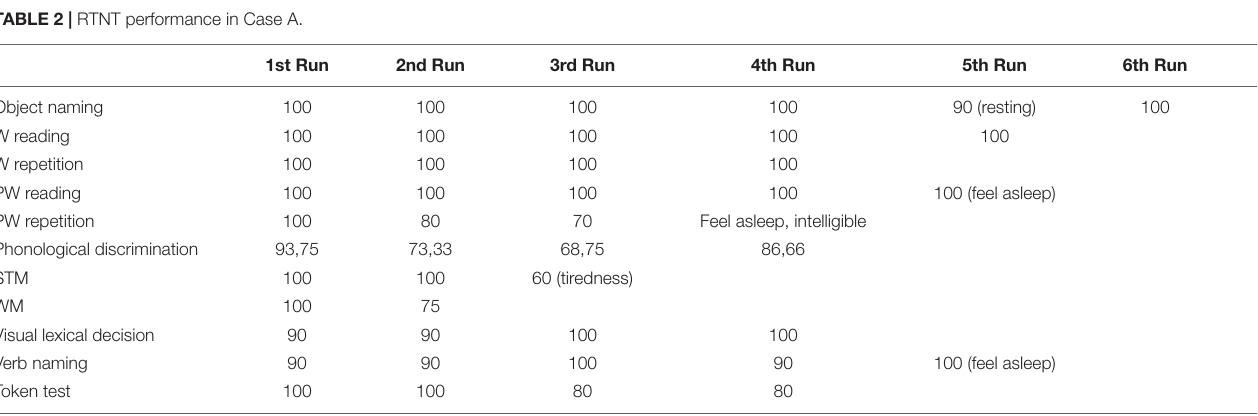
FIGURE 2 | Alternation of DES mapping and RTNT together with the RTNT protocol for left temporal resections. The first run of tasks is reported as an example. Each task includes 10 items. TABLE 2 | RTNT performance in Case